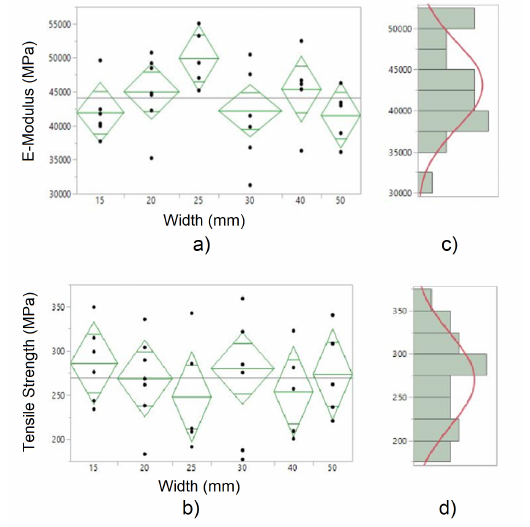
Figure 8. Oneway ANOVA: a) E -Modulus over width, b) Tensile strength over width, c) E -Modulus distribution, d) Tensile strength distribution